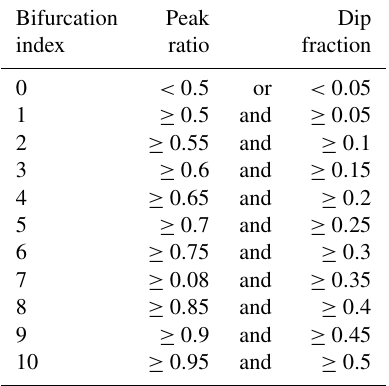
Table 1. Threshold values of peak ratio and dip fraction used to define the bifurcation index (BI).